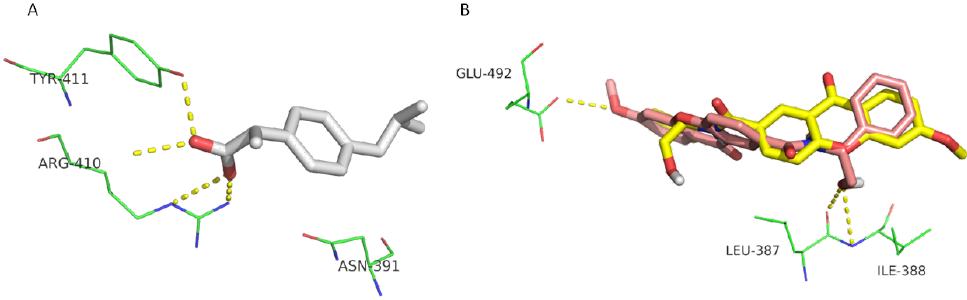
Figure 3. Interactions of crystallographic ( S )-ibuprofen (yellow sticks) ( A ) and docked CDX1 enantiomers ( B ) with HSA. ( R )- and ( S )-enantiomers are represented in pink and yellow sticks, respectively. Hydrogen interactions are represented as yellow dashes and the residues evolved are represented as green lines and labeled.